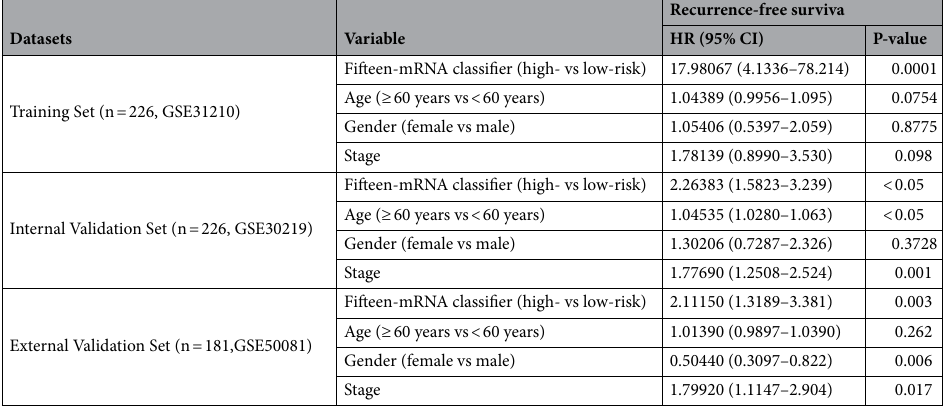
Table 4. The relationship of the fifteen-mRNA signature, clinical information (sex, age, stage) and RFS in each set analysed by multivariate Cox regression. As our data showed, the fifteen-mRNA signature was significantly related to the RFS as well as clinical characteristic in these datasets of NSCLC patients (all P <